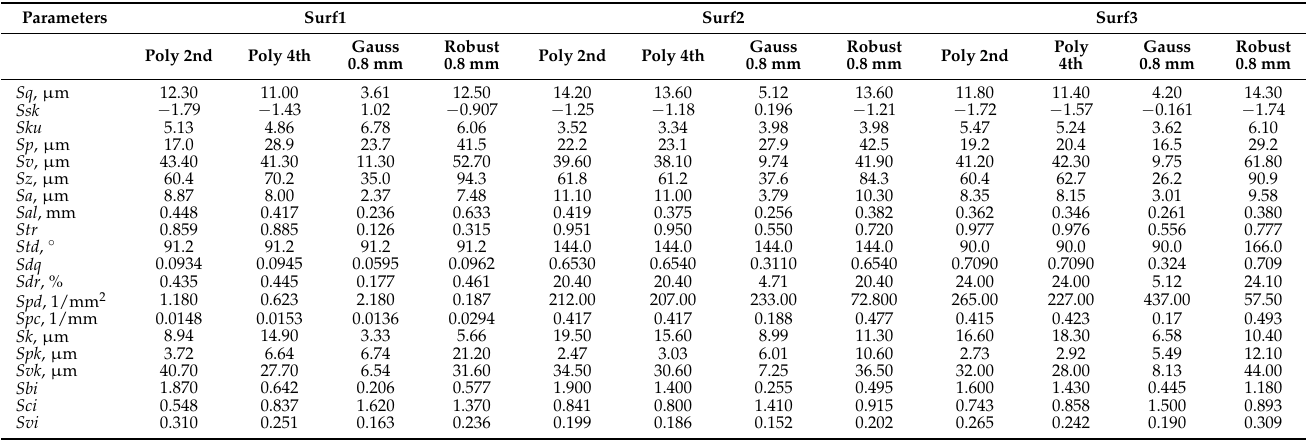
Table 2. Surface topography parameters calculated for cylindrical turned or isotropic textures with different distributions of oil pockets and after form removal by various regular procedures.